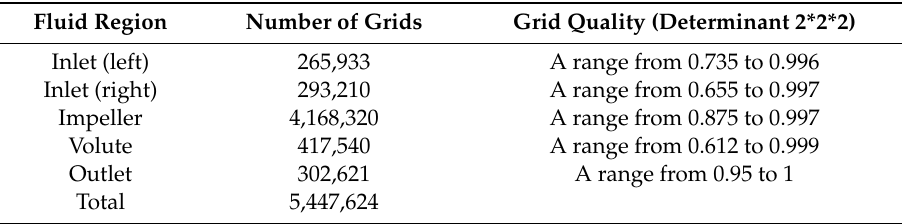
Table 2. Number of grids in each fluid region of the centrifugal